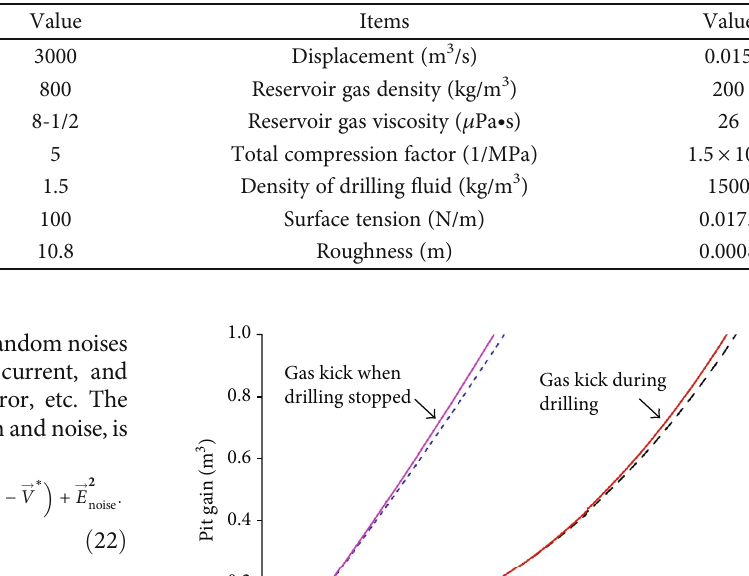
Table 1: Major parameter values used for simulation.